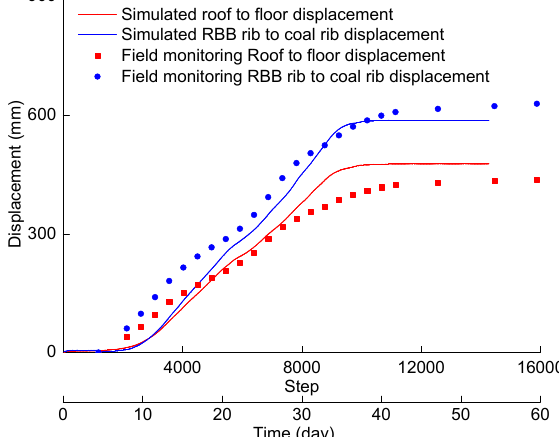
Figure 17. Comparison between the measured and simulated GER displacement.